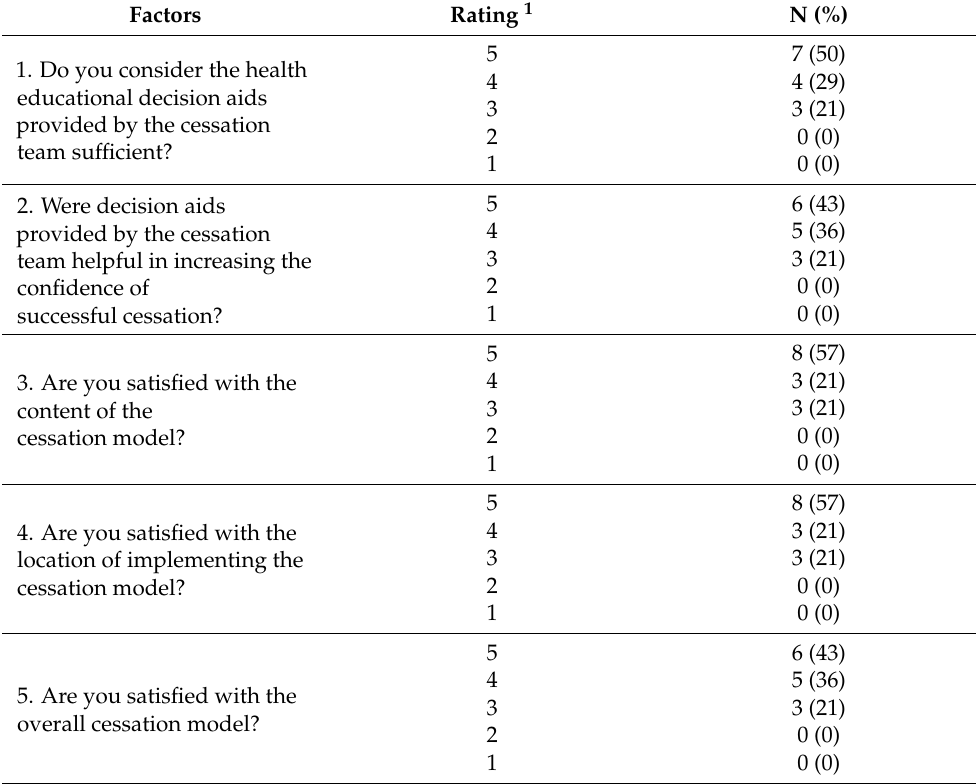
Table 3. Satisfaction of cessation model.